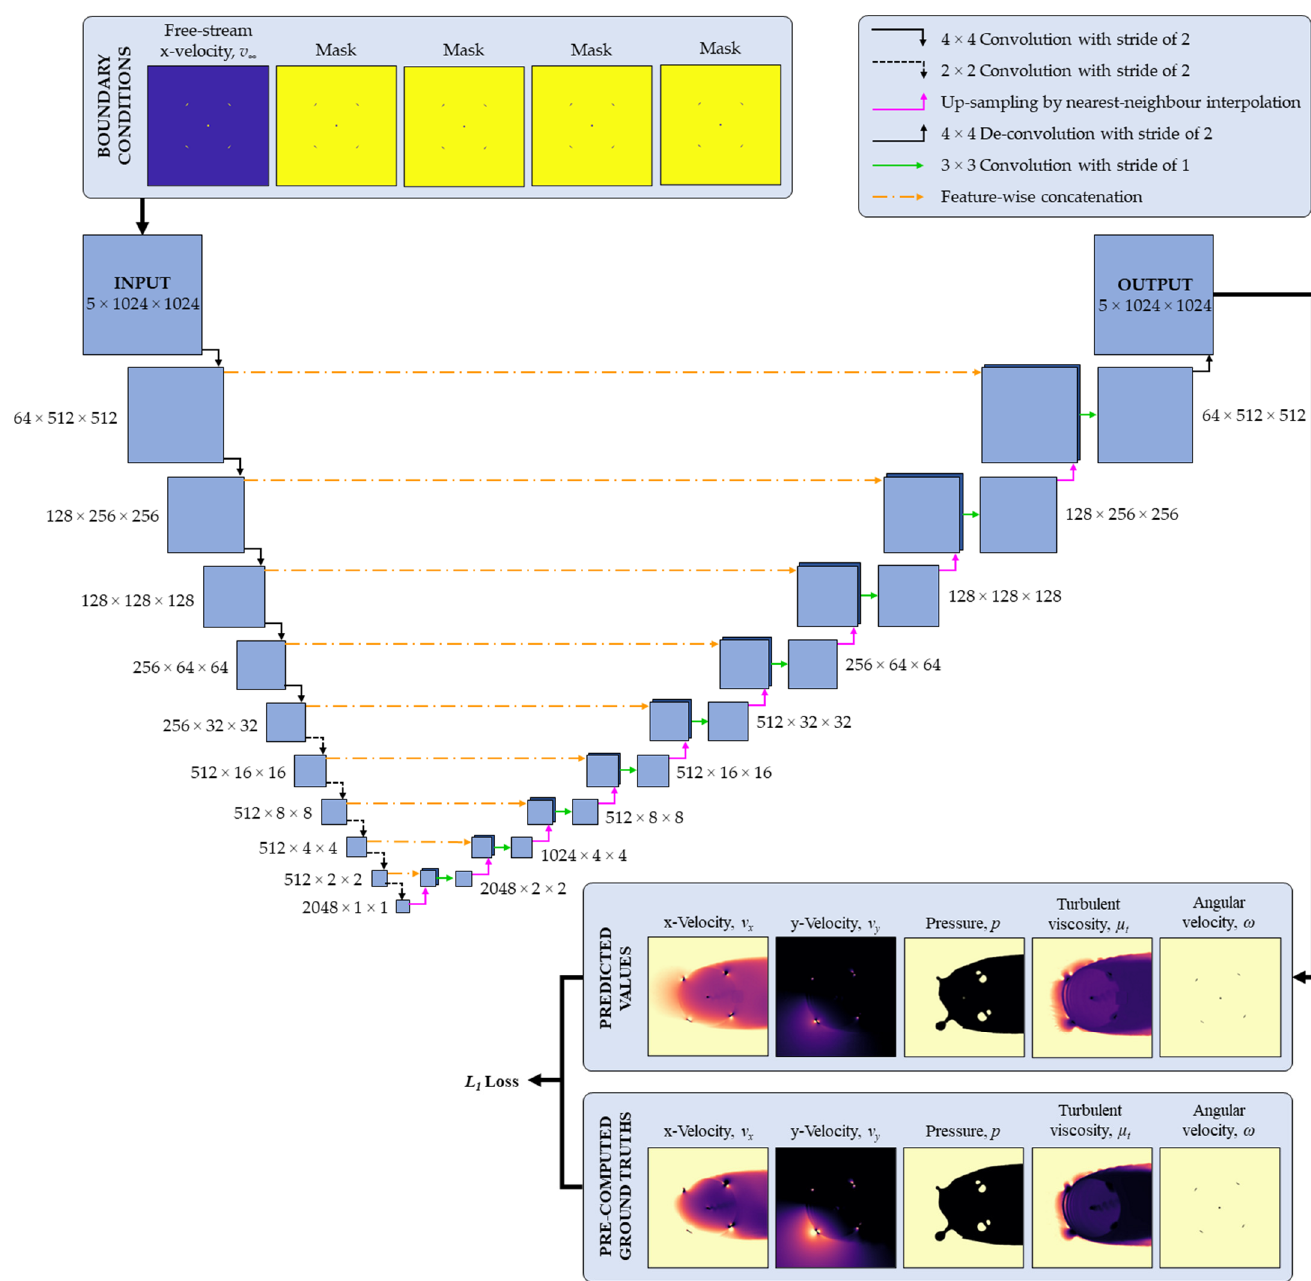
Figure 7. Large network architecture.